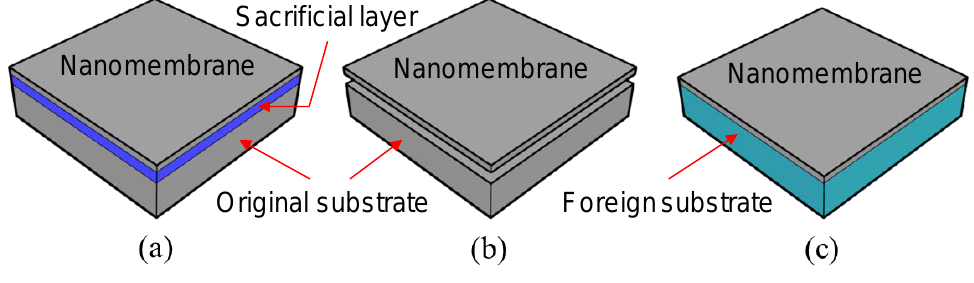
Figure 1. An illustration of the generic process for nanomembrane (NM) transfer printing. ( a ) NM on the original substrate with a sacrificial layer in-between; ( b ) NM released from the original substrate by selective removal of the sacrificial layer; ( c ) NM transfer printed onto a foreign